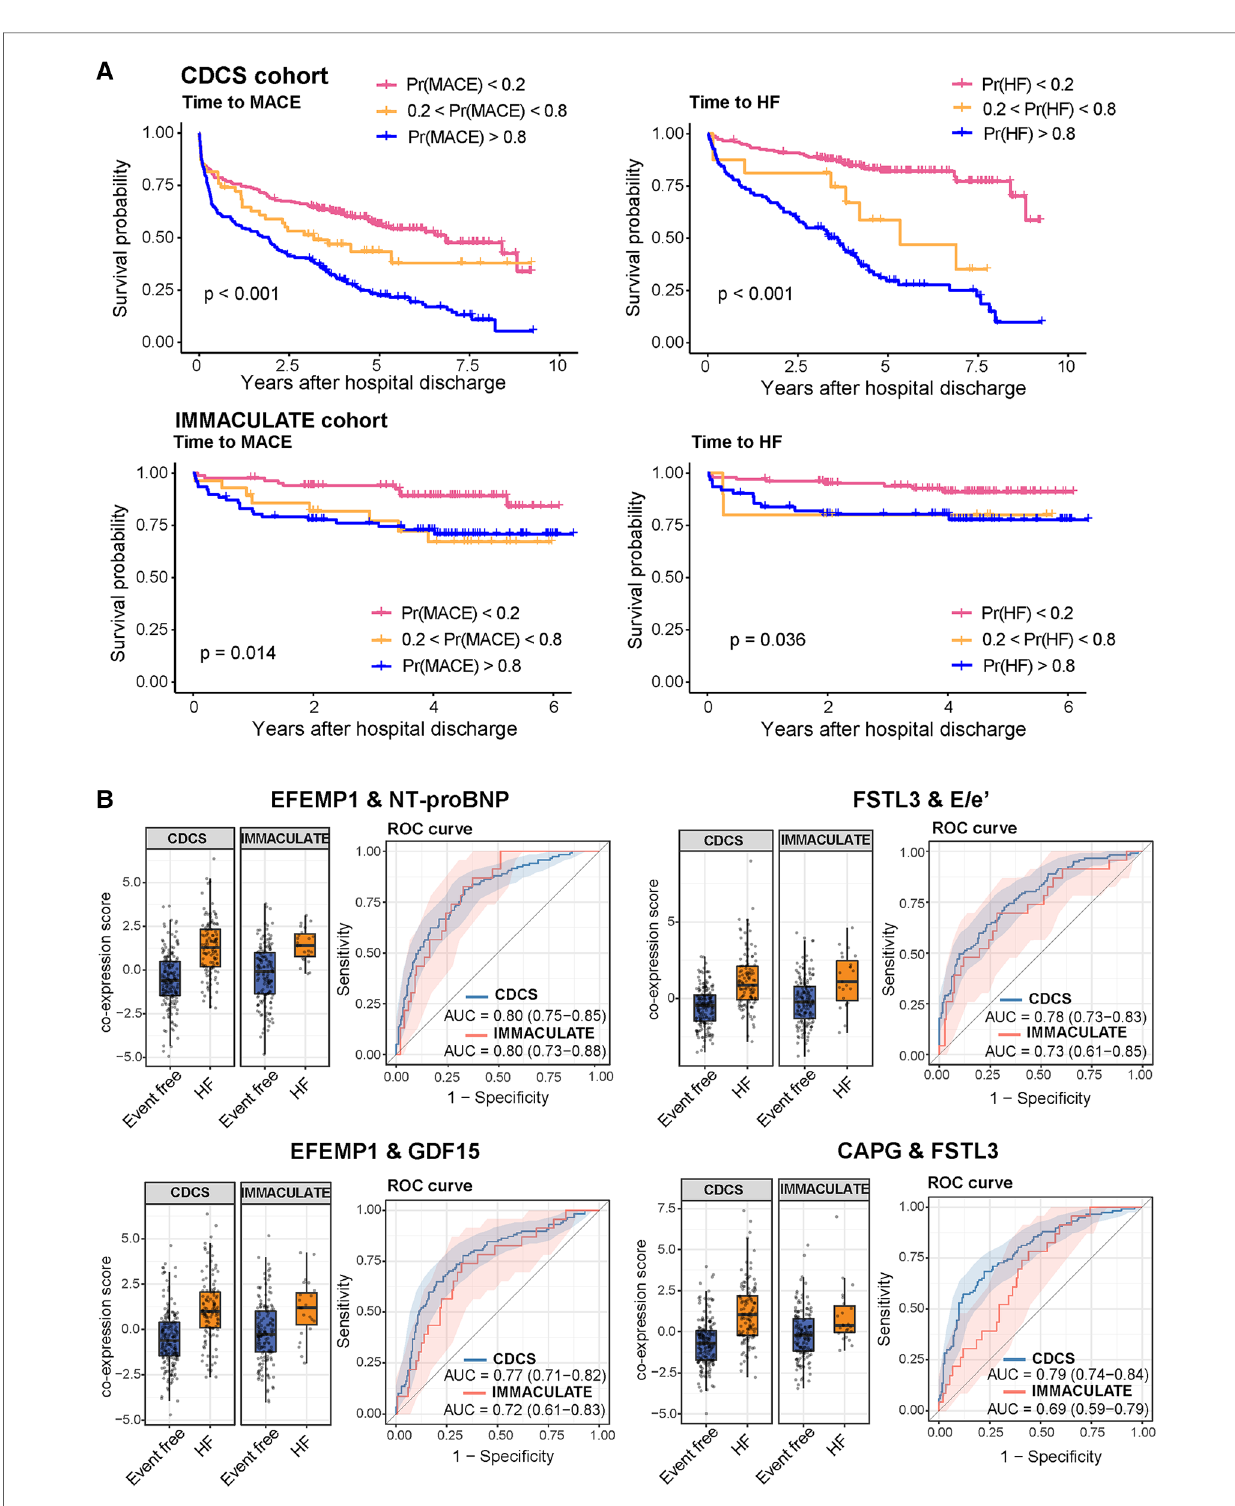
FIGURE 6 Risk strati fi cation by the iOmicsPASS probability scores of future MACE and HF events in the cohorts. ( A ) Kaplan-Meier curves with strati fi cation of patients by three categories based on the probability scores of MACE and HF in the training dataset (CDCS) and the validation dataset (IMMACULATE). ( B ) Boxplots of the co-expression scores of the four top scoring feature pairs predictive of HF and their respective ROC